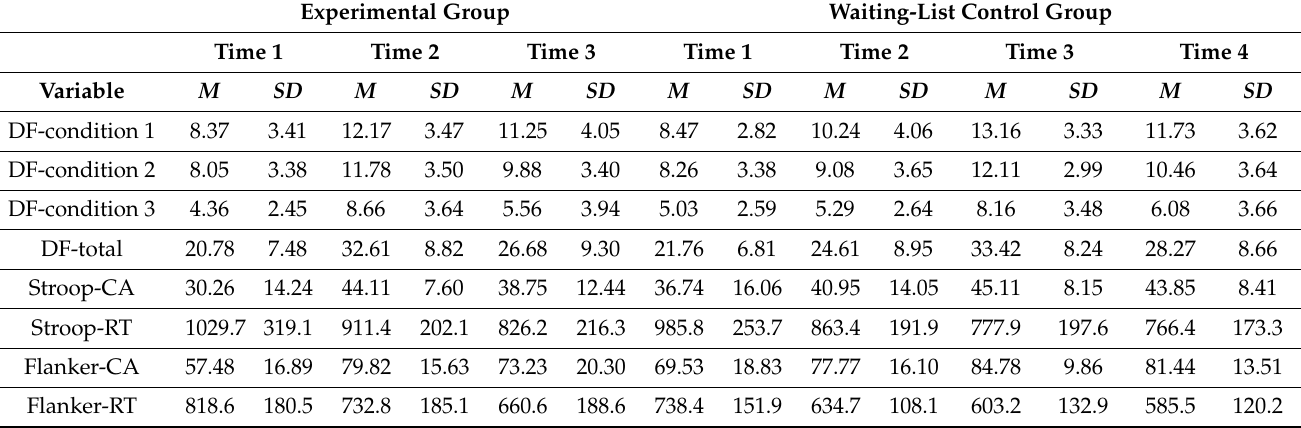
Table 2. Means and standard deviations for children’s scores in all variables measuring executive functions in all time measures of the study, separate for the experimental and the waiting-list control